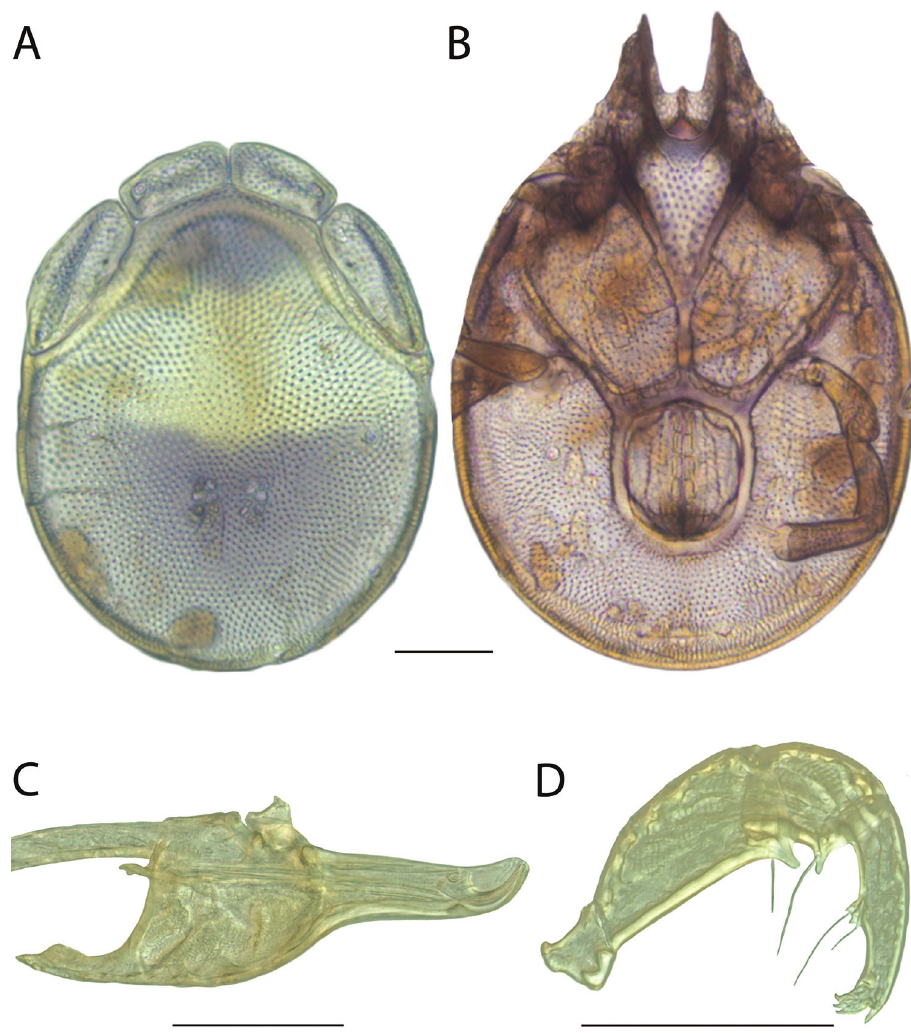
Figure 86. Torrenticola glomerabilis sp. n. male: A dorsal plates B venter (legs removed) C subcapitulum D pedipalp (setae not accurately depicted). Scale = 100